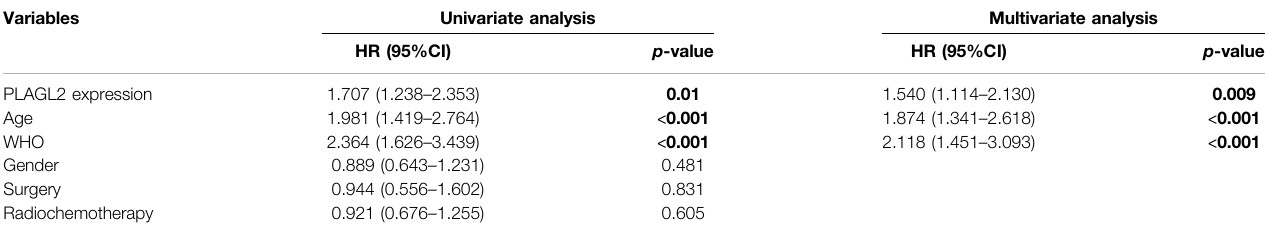
TABLE 3 | Univariate and multivariate Cox proportional hazards analysis of OS in HGG cohort.